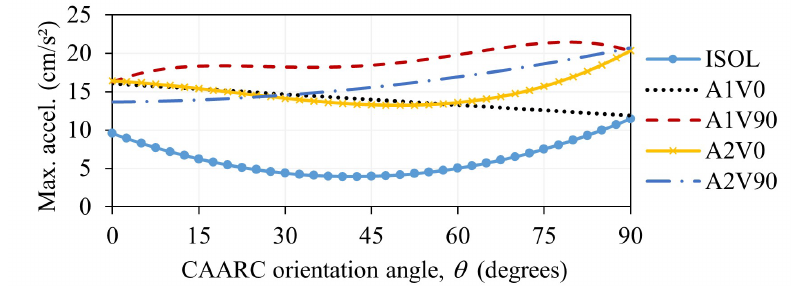
Figure 6. Maximum acceleration at the top of the CAARC,